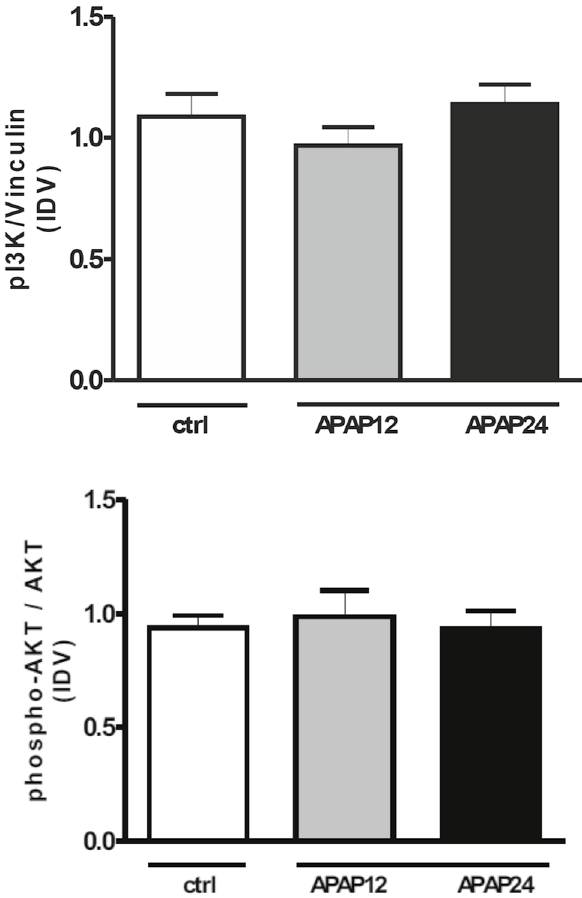
Figure 2. Changes in upstream signaling of protein synthesis. Upper panel Amount of Pi3K 12 or 24 h after APAP treatment. Lower panel changes of phosphorylated AKT vs AKT 12 or 24 h after APAP treatment. Pi3K phosphatidyl-inositol Kinase 3; AKT Protein kinase B; there is no change in these parameters. APAP 12 N-acetyl-para-amino phenol 12 h treatment; APAP 24 N-acetyl-para-amino phenol 24 h treatment, ctrl controls, IDV integrated density value. Values are mean and standard deviation.